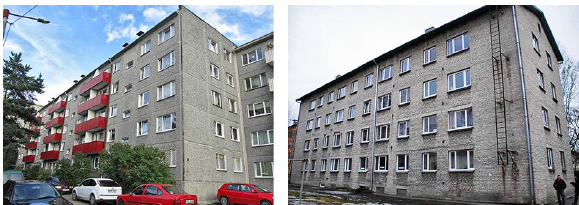
Fig. 1. Typical prefabricated reinforced concrete large-panel element apartment building (left) and brick apartment building